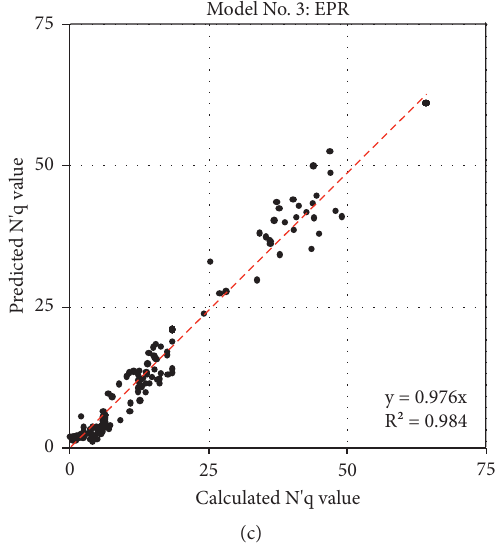
Figure 4: Relation between the predicted and calculated N ′ q values using the developed (a) GP, (b) ANN, and (c) EPR models.